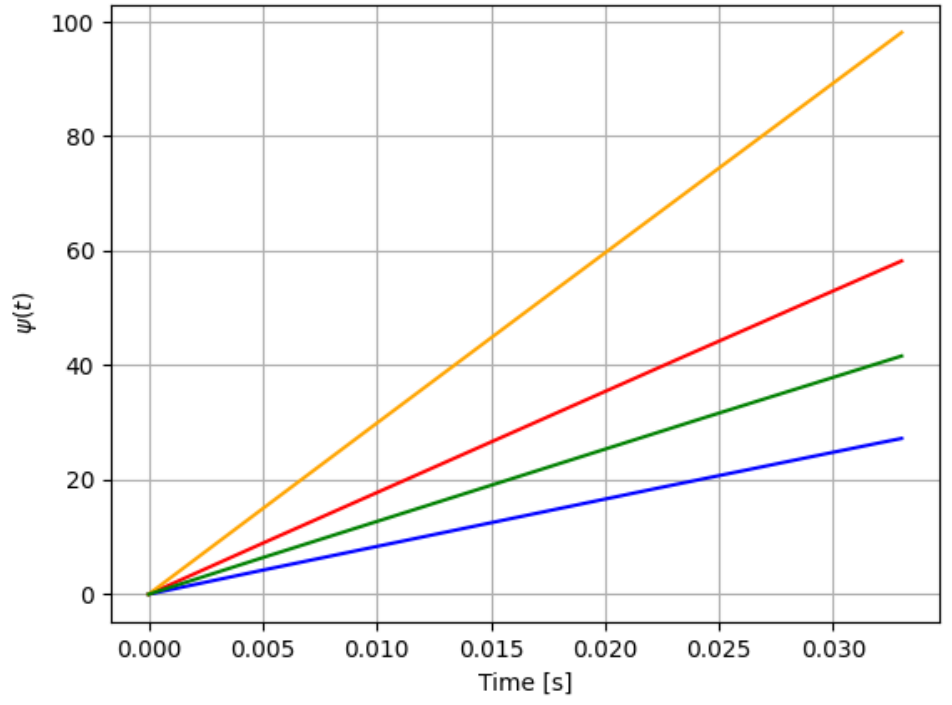
Figure 4. First simulation: data fusion raw ψ ( t ) in (4) for each case in Table 1: H (blue), F 1 (red), F 2 (orange), and F 3 (green). Notice that the fault detection is